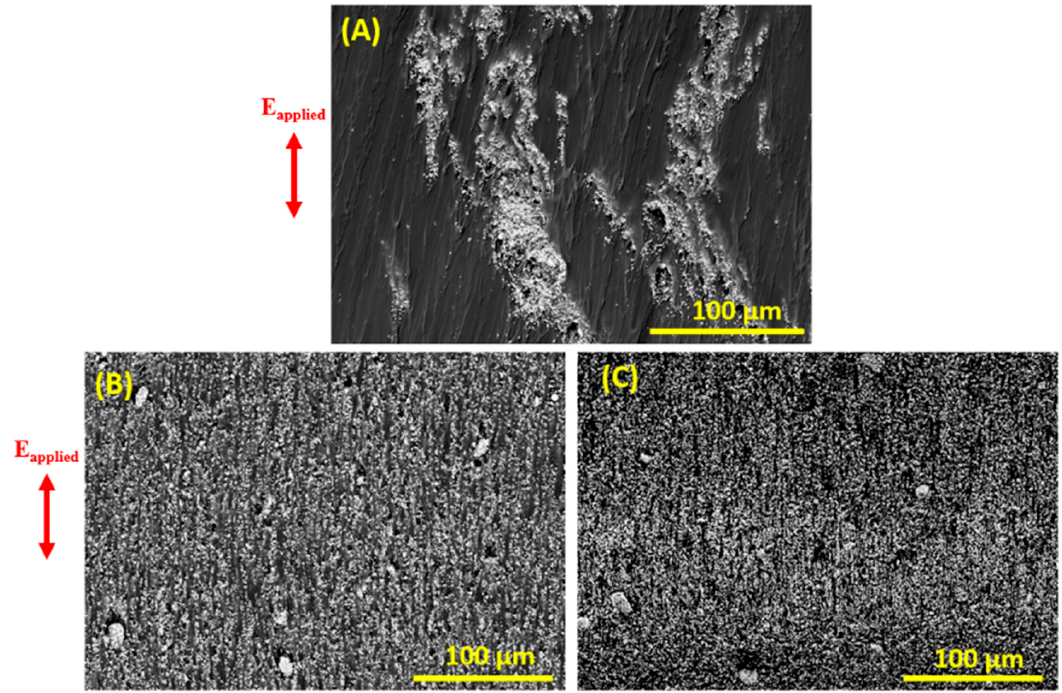
Figure 5. SEM micrographs of EVA/BaTiO 3 composites structured at 6 kV.mm – 1 : ( A ) 3 vol% filler content, ( B ) 16 vol% filler content, ( C ) 29 vol% filler content.